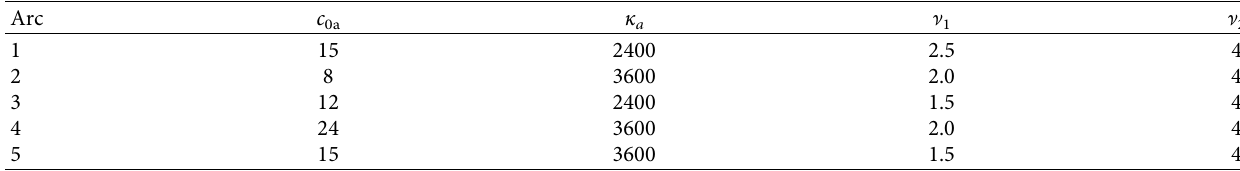
Figure 1: The toy network. Table 1: Parameters of arc cost functions.